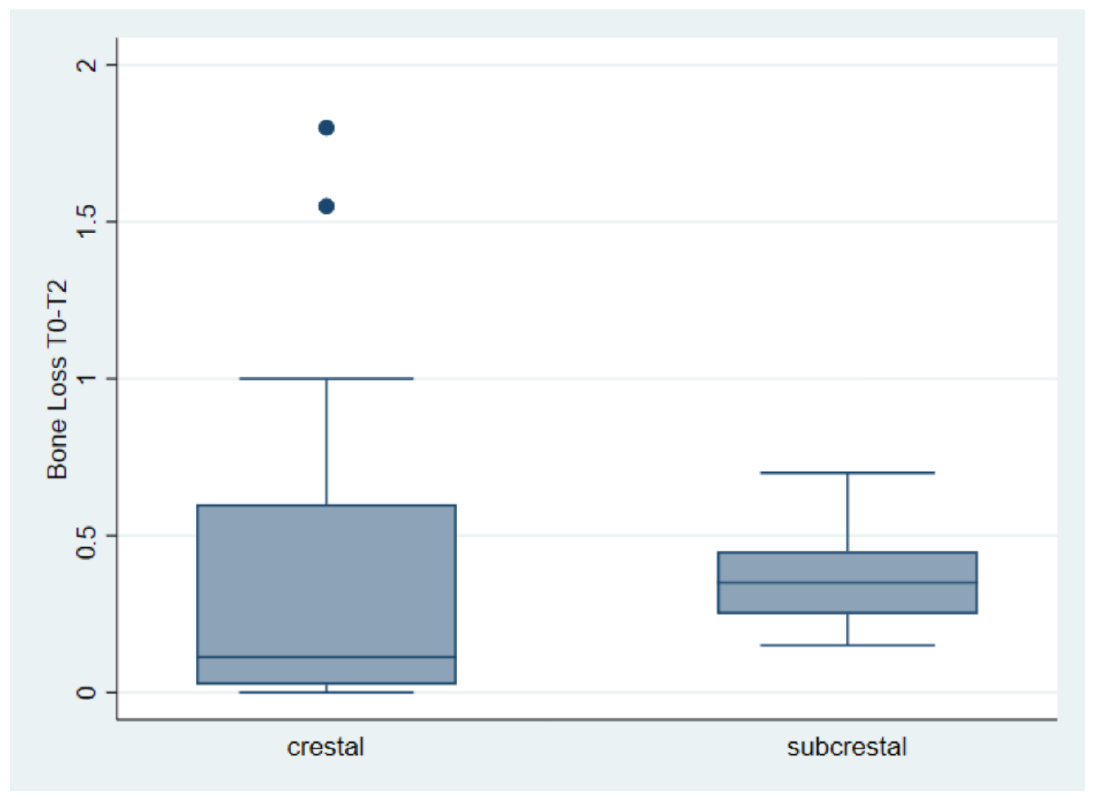
Figure 5. Bone loss (mm) in crestal vs. subcrestal implants between the first and third measurement (T0 – T2). 0.359 and 0.367 mm, respectively, for the implant placed at the crestal and subcrestal level.